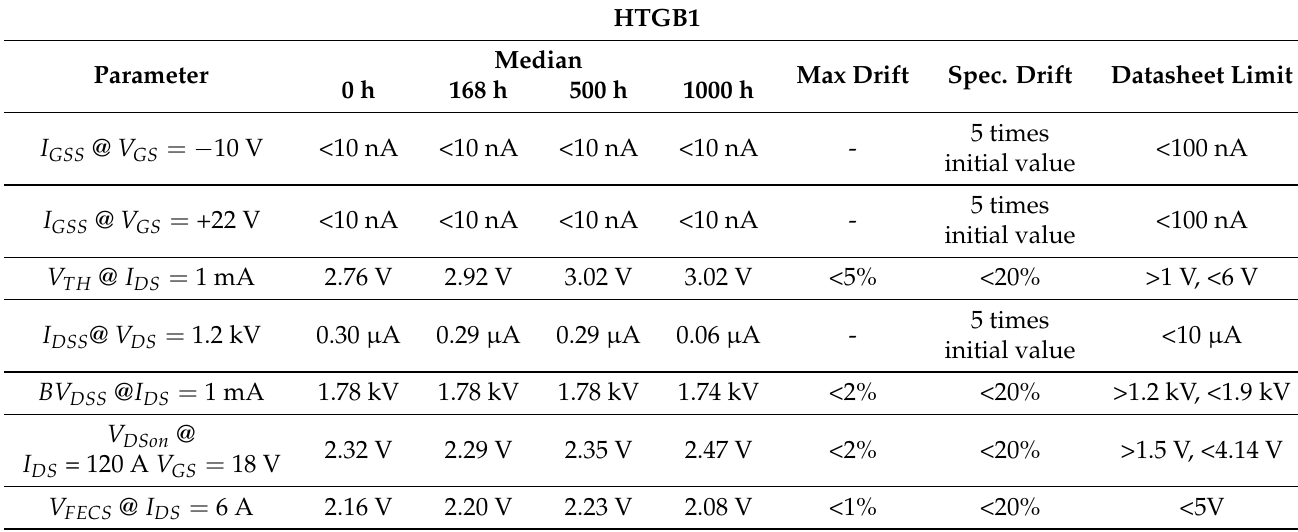
Table 6. Drifts of some GEN3 SiC MOSFET electrical parameters for the HTGB1 test.